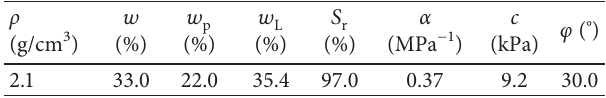
Table 1: Physical and mechanical properties of the saturated silty